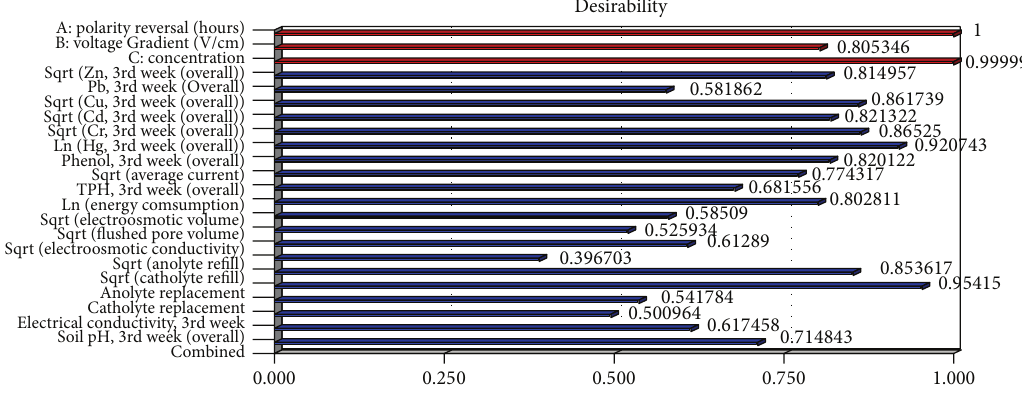
Figure 15: Combined and individual response desirability values for all responses and factors.